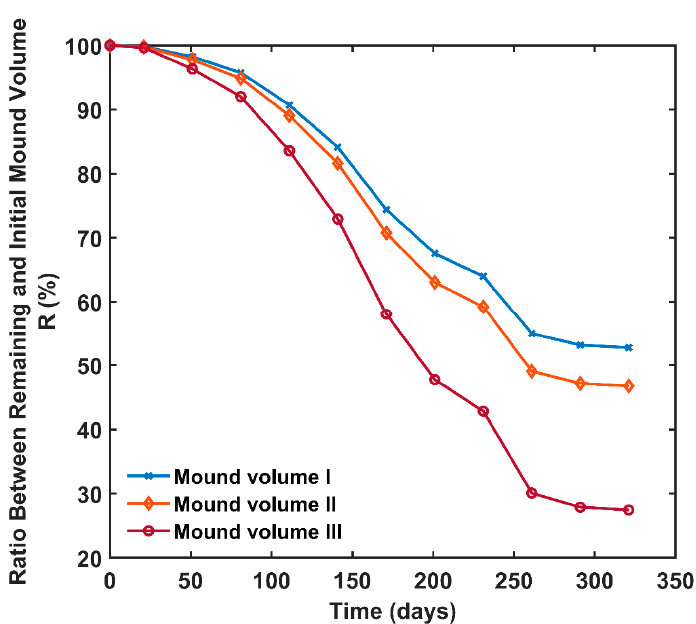
Figure 10. The ratio change between remaining and initial mound volume with time.